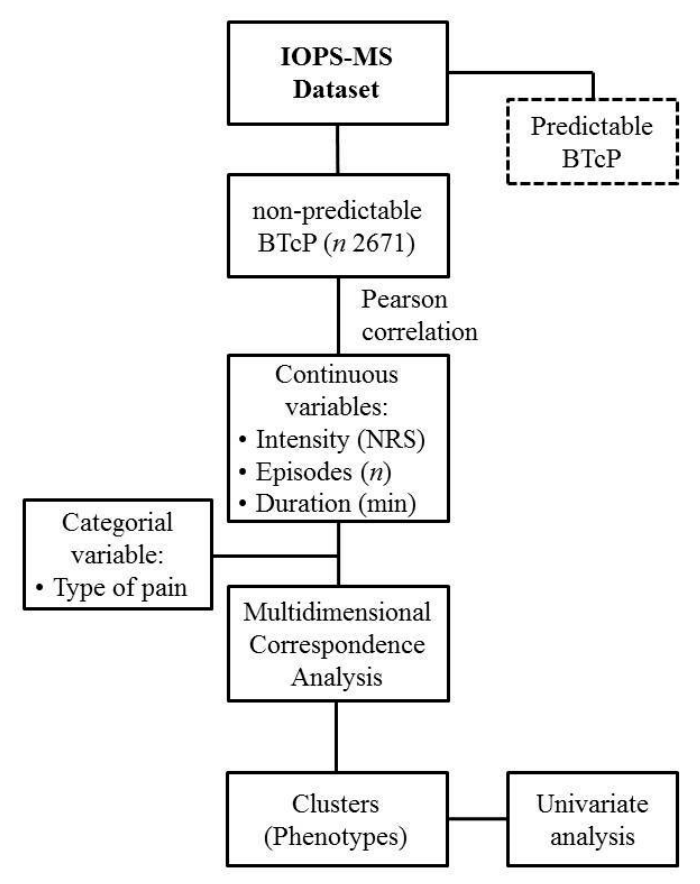
Figure 1. Flow chart. Abbreviations. IOPS—Italian Oncological Pain Survey; BTcP—breakthrough cancer pain; NRS—numerical rating